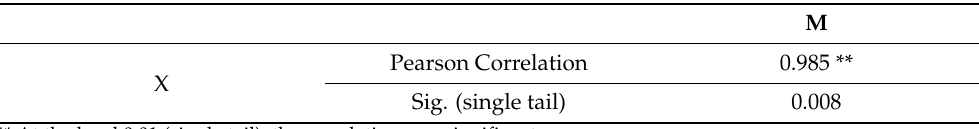
Table 6. Correlation test of microstructure parameters and residual ash.